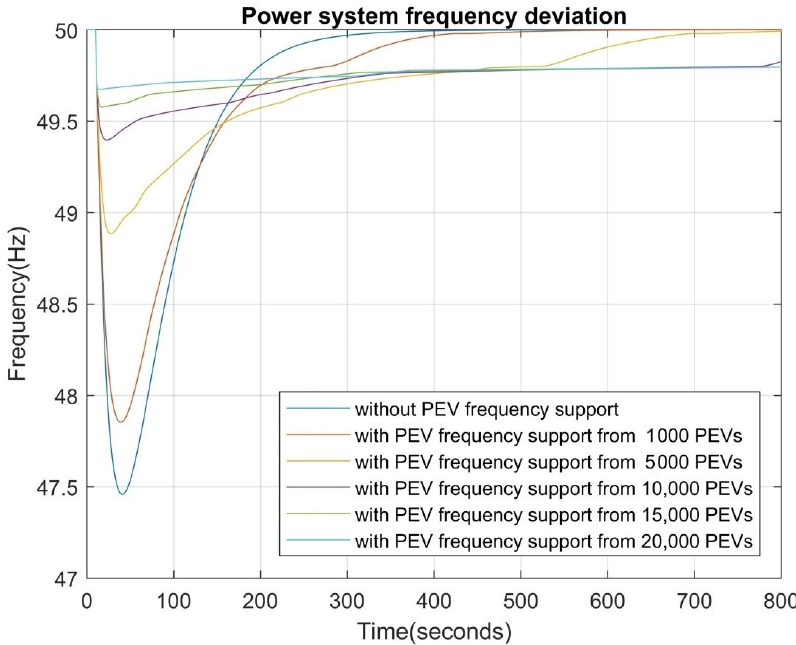
Figure 11. Frequency support according to the number of connected vehicles.